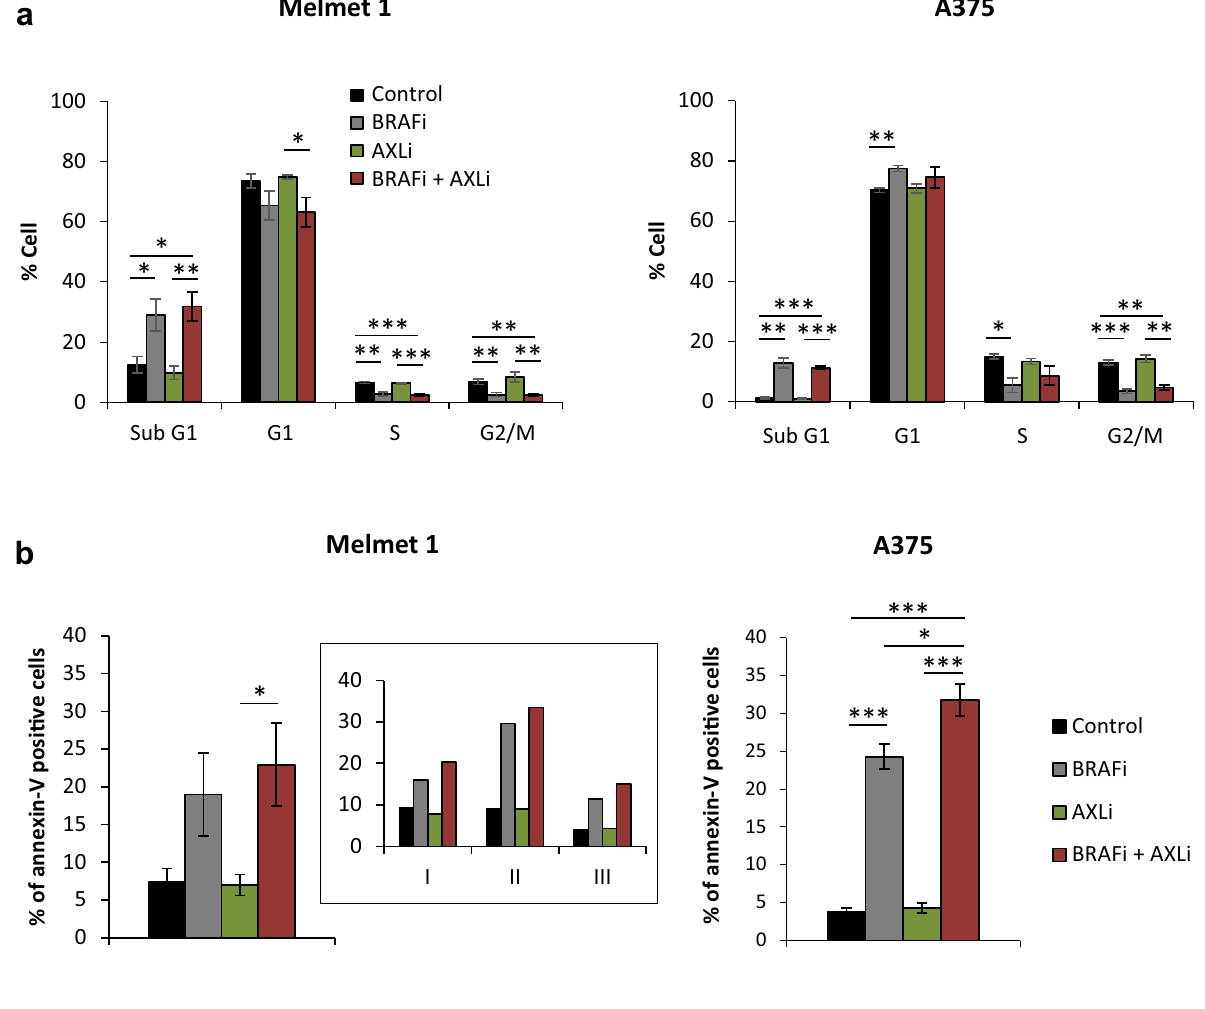
Figure 5. Apoptosis induction in melanoma cells following combined inhibition of AXL and BRAF. Melmet 1 and A375 cells were treated with 2 µM BRAFi, 2 µM AXLi or a combination of both, DMSO for control for 48 h, stained with Hoechst ( a ) or annexin-V ( b ) and analyzed by flow cytometry. Insert in ( b ) represents the % of annexin-V positive Melmet 1 cells from three independent biological experiments. Average ± SEM, n = 3. * p ≤ 0.05; ** p ≤ 0.01; *** p ≤